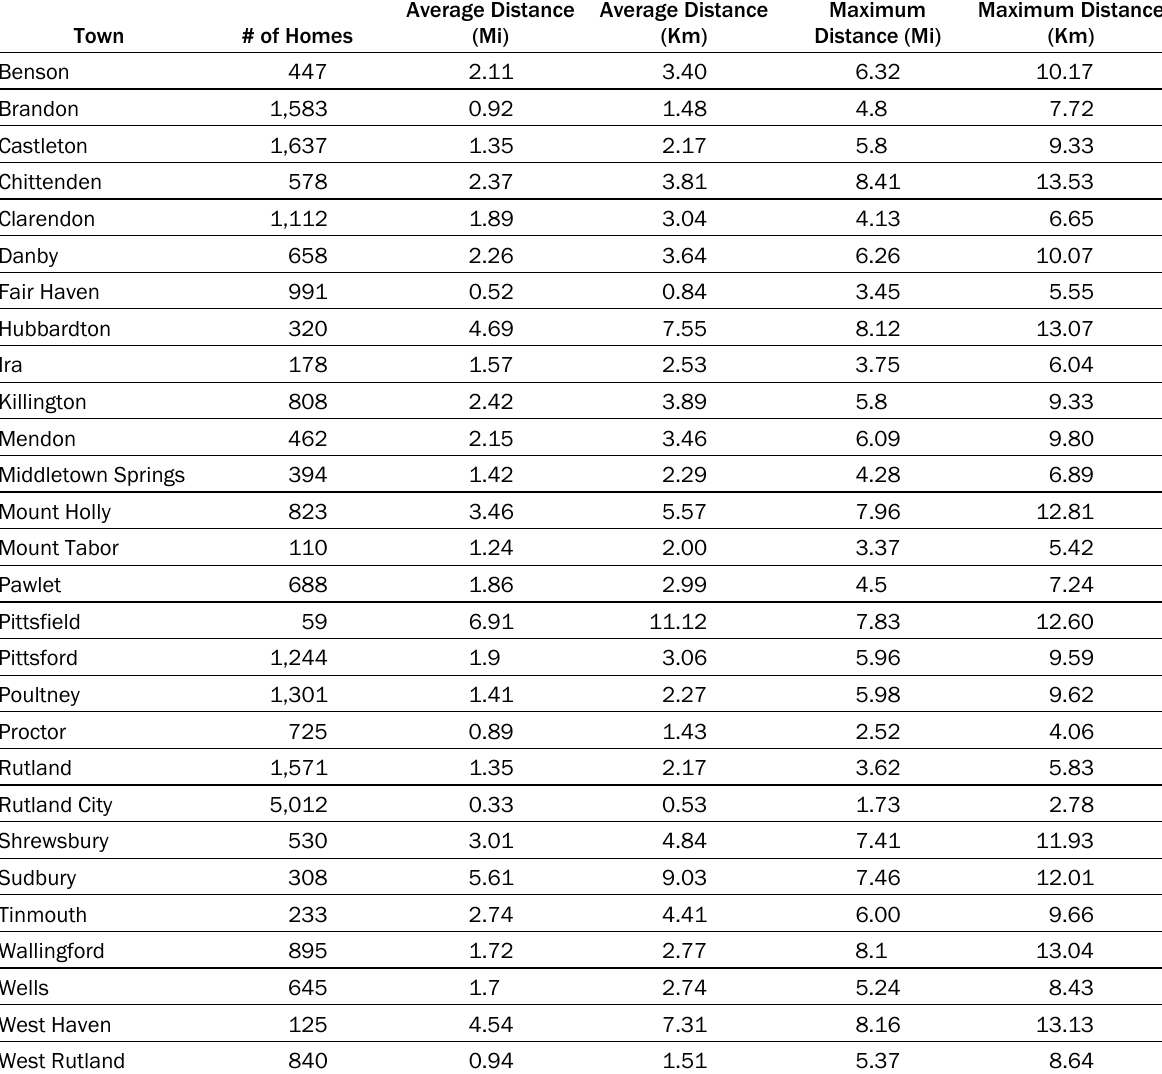
Table 3. Summary of the Average and Maximum Travel Distance Between Residential Buildings and All Food Providers in Rutland